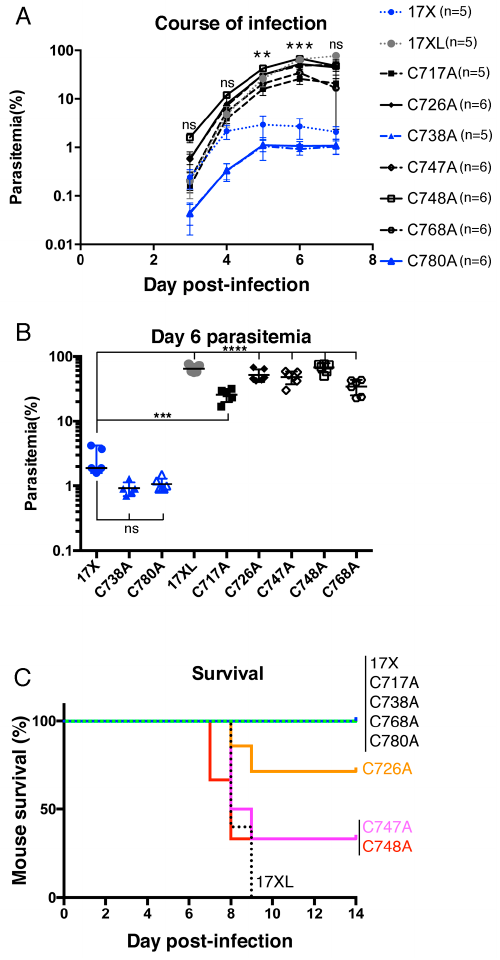
Figure 2. Effect of substituting Cys to Ala in PyEBL region 6 (n = 5~6 per group). Mice were intravenously inoculated with 1 × 10 4 parasitized erythrocytes. 17X and 17XL represent the P. yoelii 17X and 17XL wild-type parasite strains, respectively. The names of the transgenic parasite lines are shown as an abbreviation of the position of the Cys to Ala substitution. ( A ) Infection courses in mice are presented by parasitemias from days 3 to 7. ( B ) Parasitemia on day 6. The difference was evalu- ated with Prism 6.0 software with a post-hoc test. ( C ) Survival curve of infected mice. All mice in- fected with the 17XL strain died by day 9. Some mice infected with C726A, C747A, or C748A died by day 9, but the remaining mice survived until day 14. All mice infected with other lines survived until day 14. The statistical significance of the parasitemia was tested against the 17X parental line by one-way ANOVA with Dunnett’s multiple comparison test; **, ***, and **** indicate p < 0.01, p < 0.001, and p < 0.0001, respectively. ns, not significant.